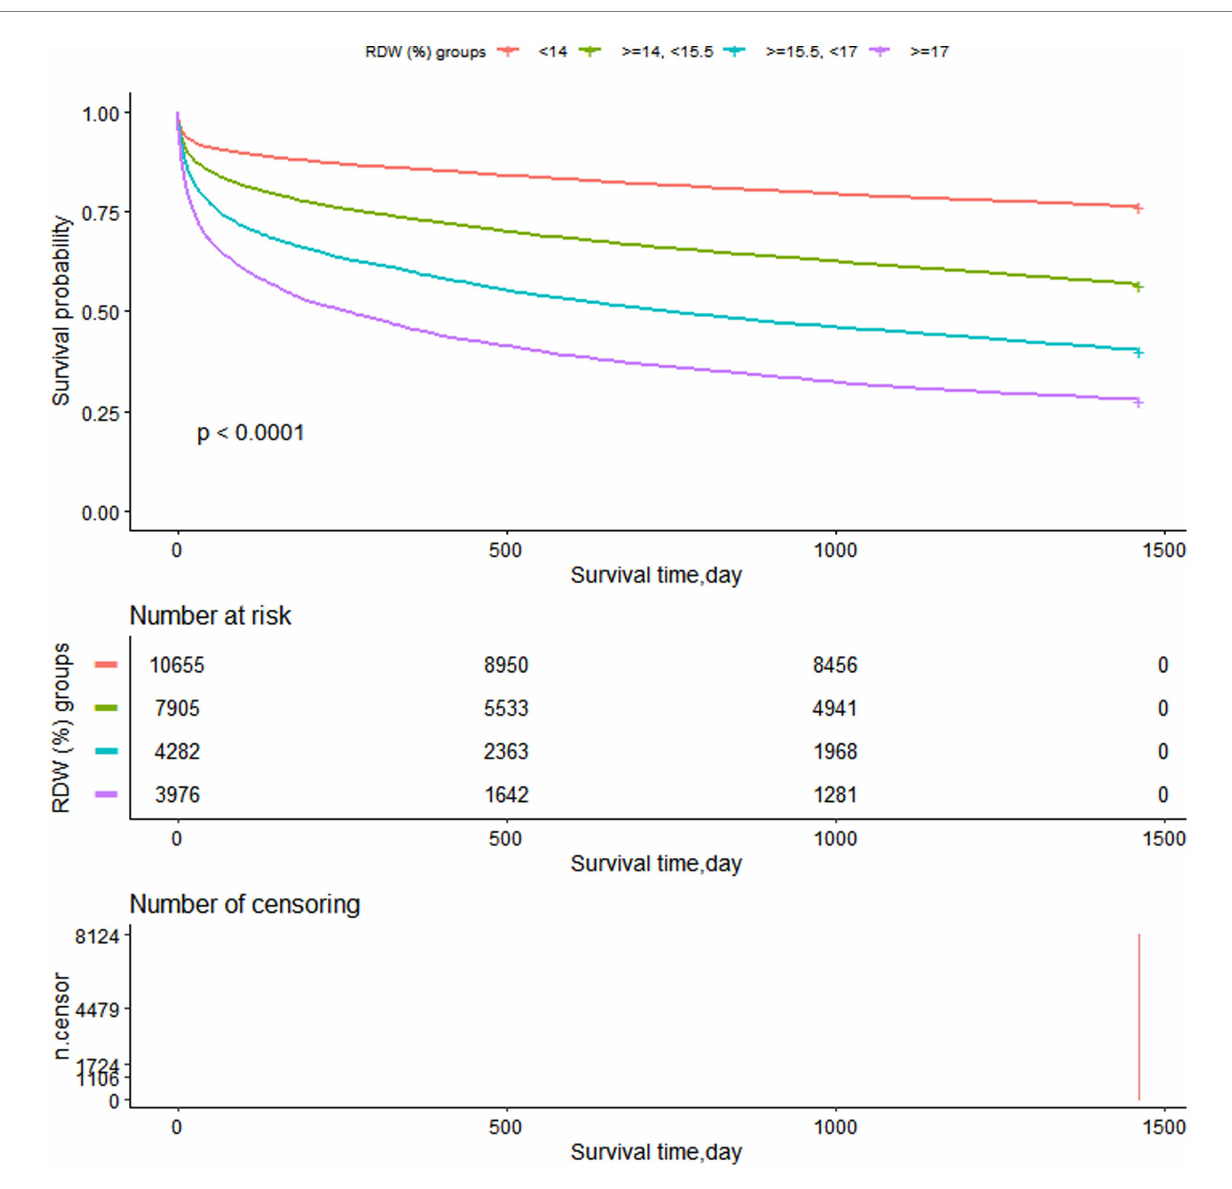
FIGURE 6 Kaplan–Meier survival curves demonstrating differences in overall survival